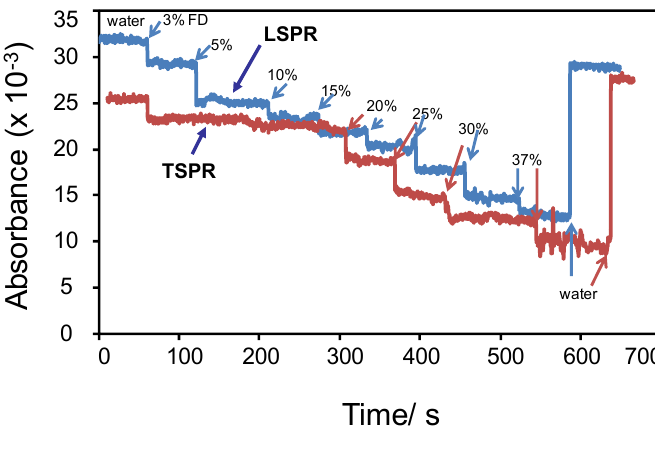
Figure 9. Dynamic response of GNR under variation of FD concentrations measured at the plasmonic peak, namely 552